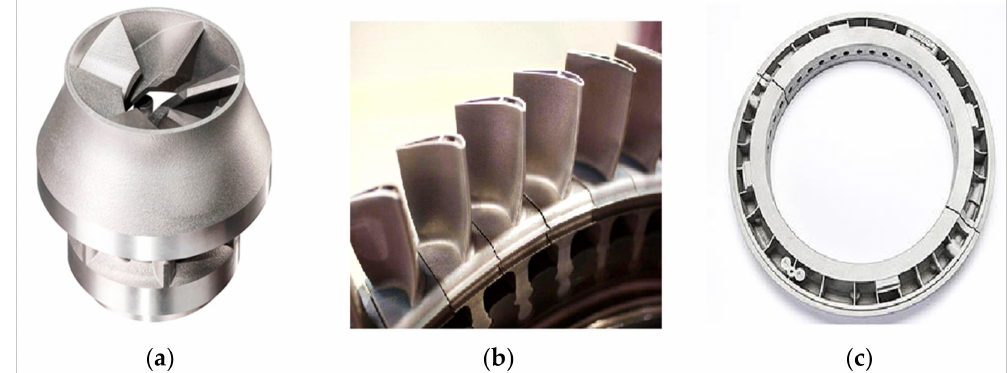
Figure 9. Siemens Oil and Gas AM components [103]: ( a ) burner head, ( b ) turbine blade, and ( c ) sealing